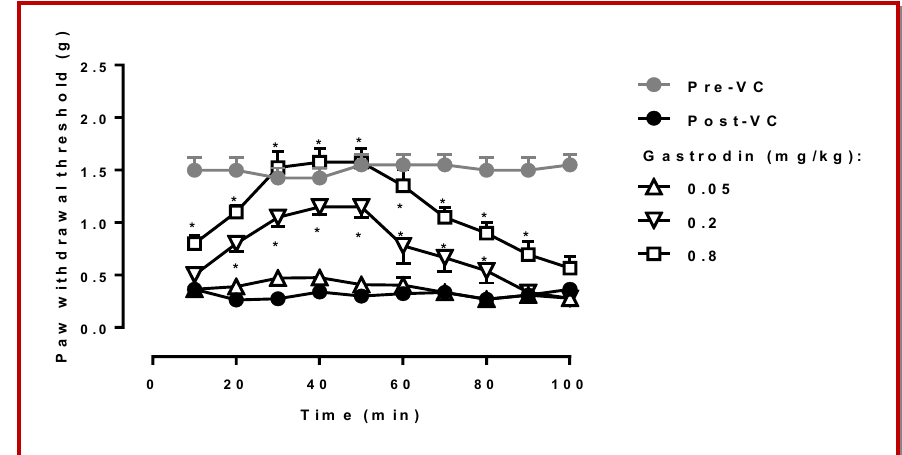
Figure 2: Anti-hyperalgesic effect of gastrodin in mice (n=8 per group). *p<0.05 as compared to corresponding post-CV baseline data. VC, vincristine